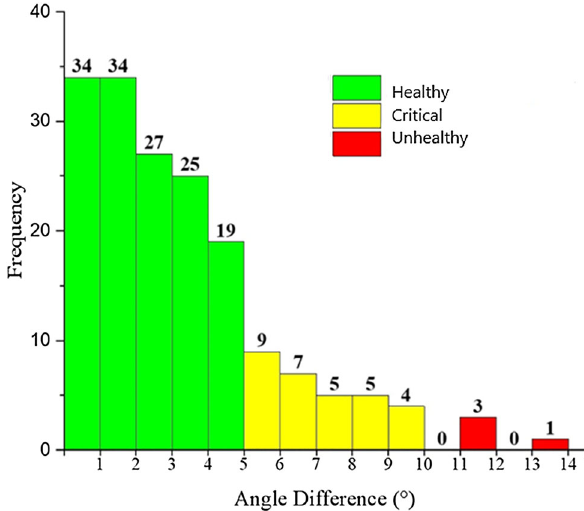
Fig. 6 Distribution of the pole inclination angles of the 173 utility poles in the Beaumont, Texas, case study site Fig. 7 Example output images of utility poles with calculated inclination